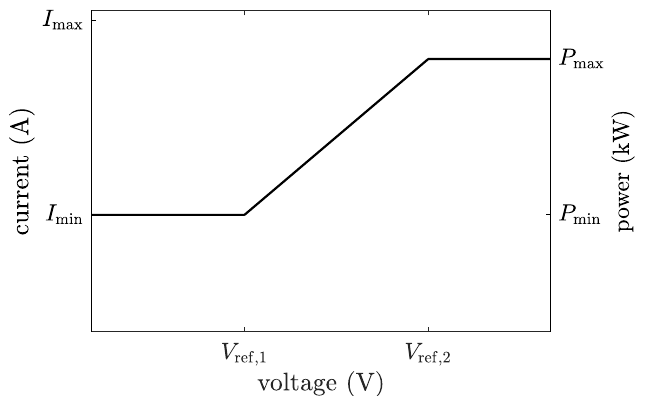
Figure 2. Voltage droop characteristics for EV charging current